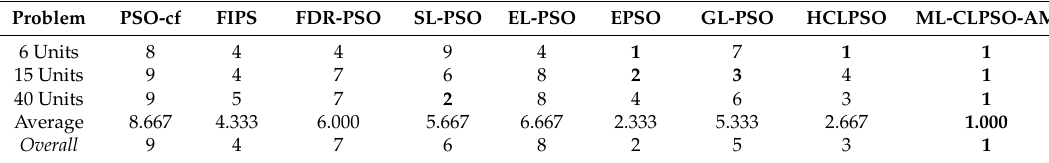
Table 7. Rank of mean cost among PSO algorithms on ELD